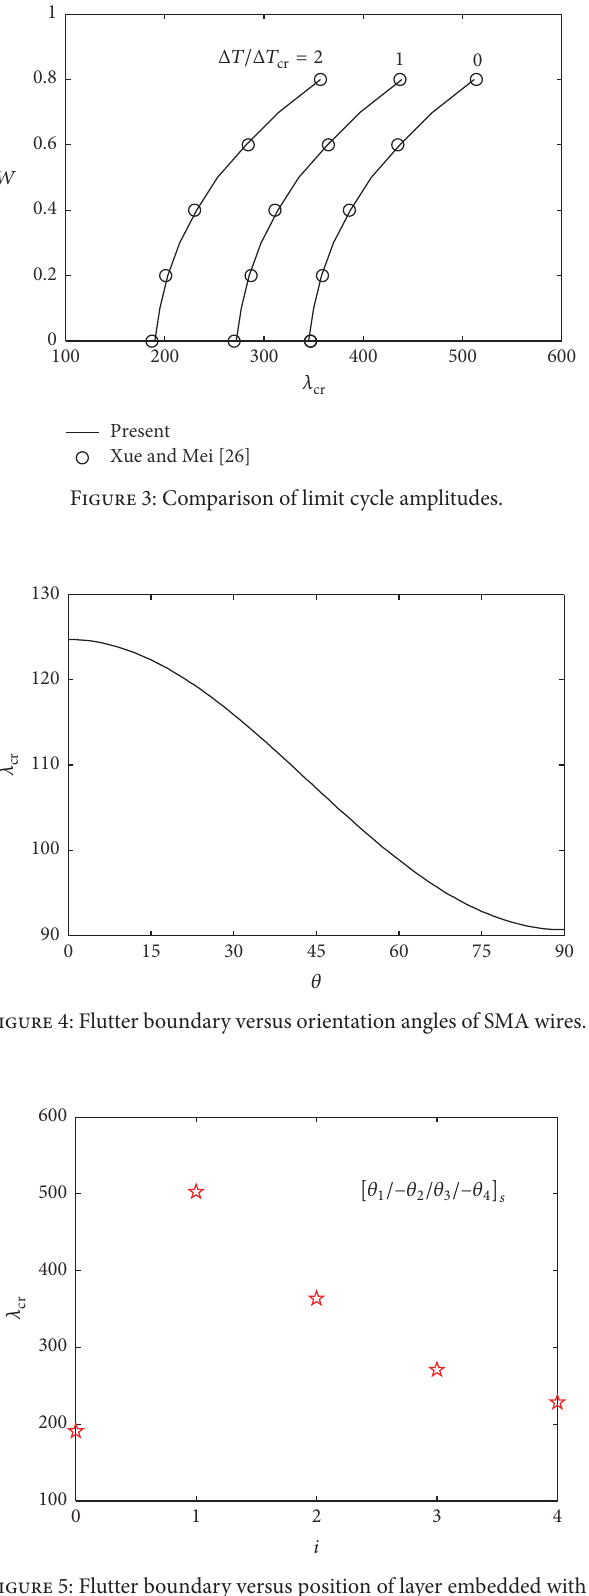
; 𝑖 = 1 , [ 0 SMA / − 60/60/ − 60] s ; 𝑖 = 3 , [60/ − 60/ 0 SMA / − 60] s .). s